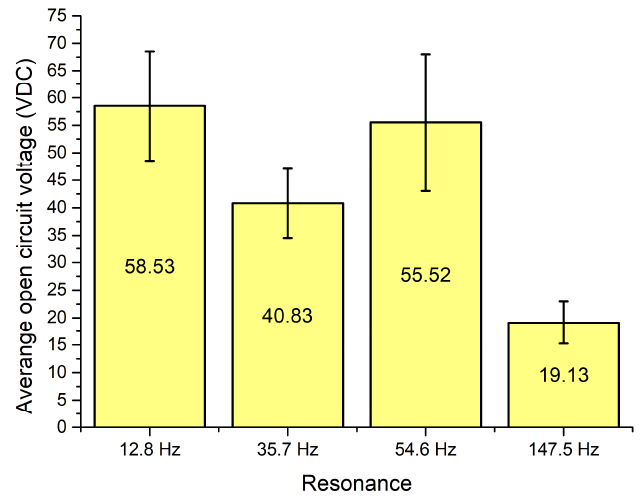
Figure 16. Summary of average open circuit voltage over angular range.